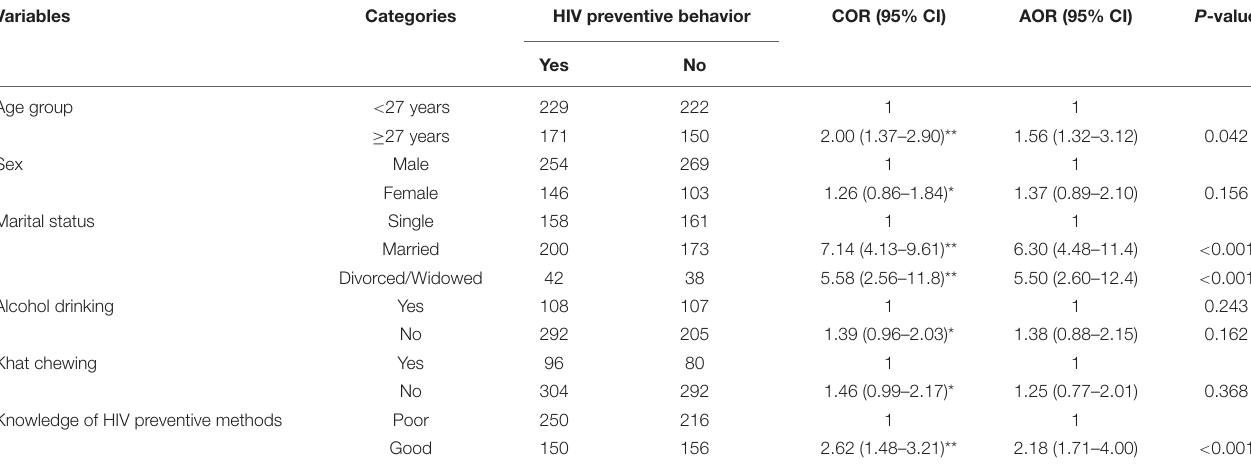
TABLE 3 | Factors associated with HIV preventive behavior in the Majang zone, Southwest Ethiopia,